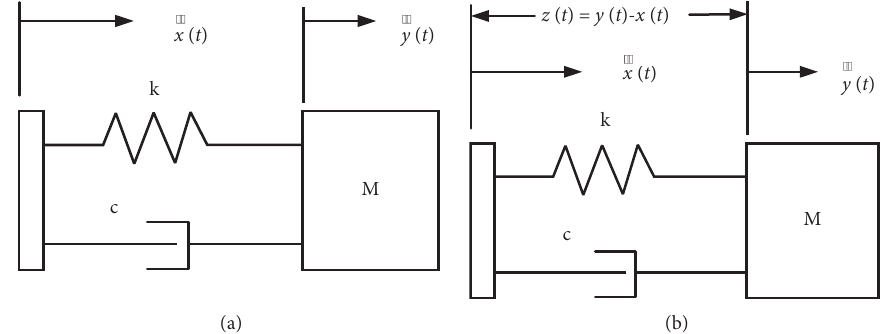
Figure 2: Response model of foundation vibration. Then the transfer function of the model can be obtained: (a) Absolute acceleration response model. (b) Relative displacement response